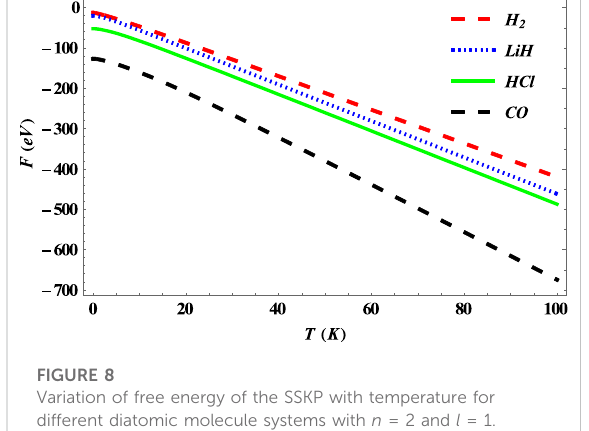
FIGURE 11 Variation of the speci fi c heat capacity of the SSKP with temperature for different diatomic molecule systems with n = 2 and l =